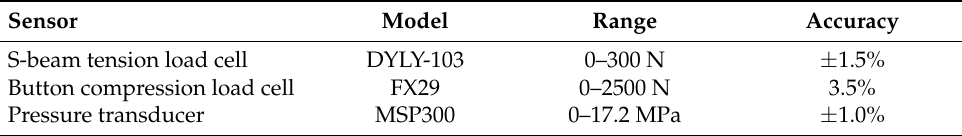
Table A1. Sensor name, model, maximum operating range, and absolute accuracy.